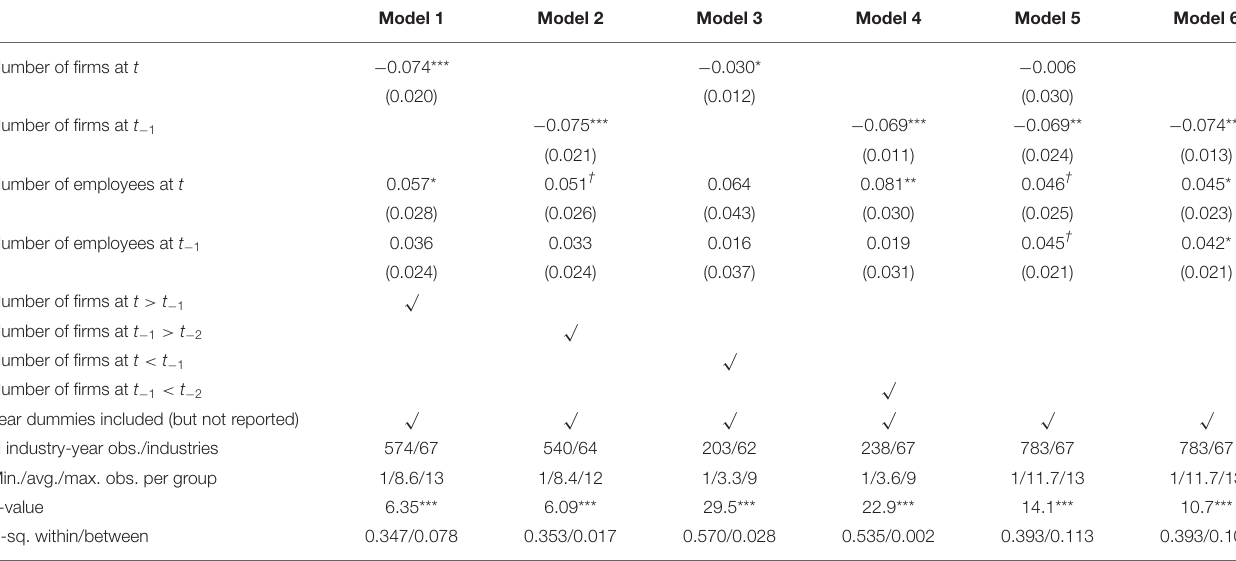
TABLE 1 | Fixed effects panel regressions with robust standard errors and firm size inequality at t as dependent